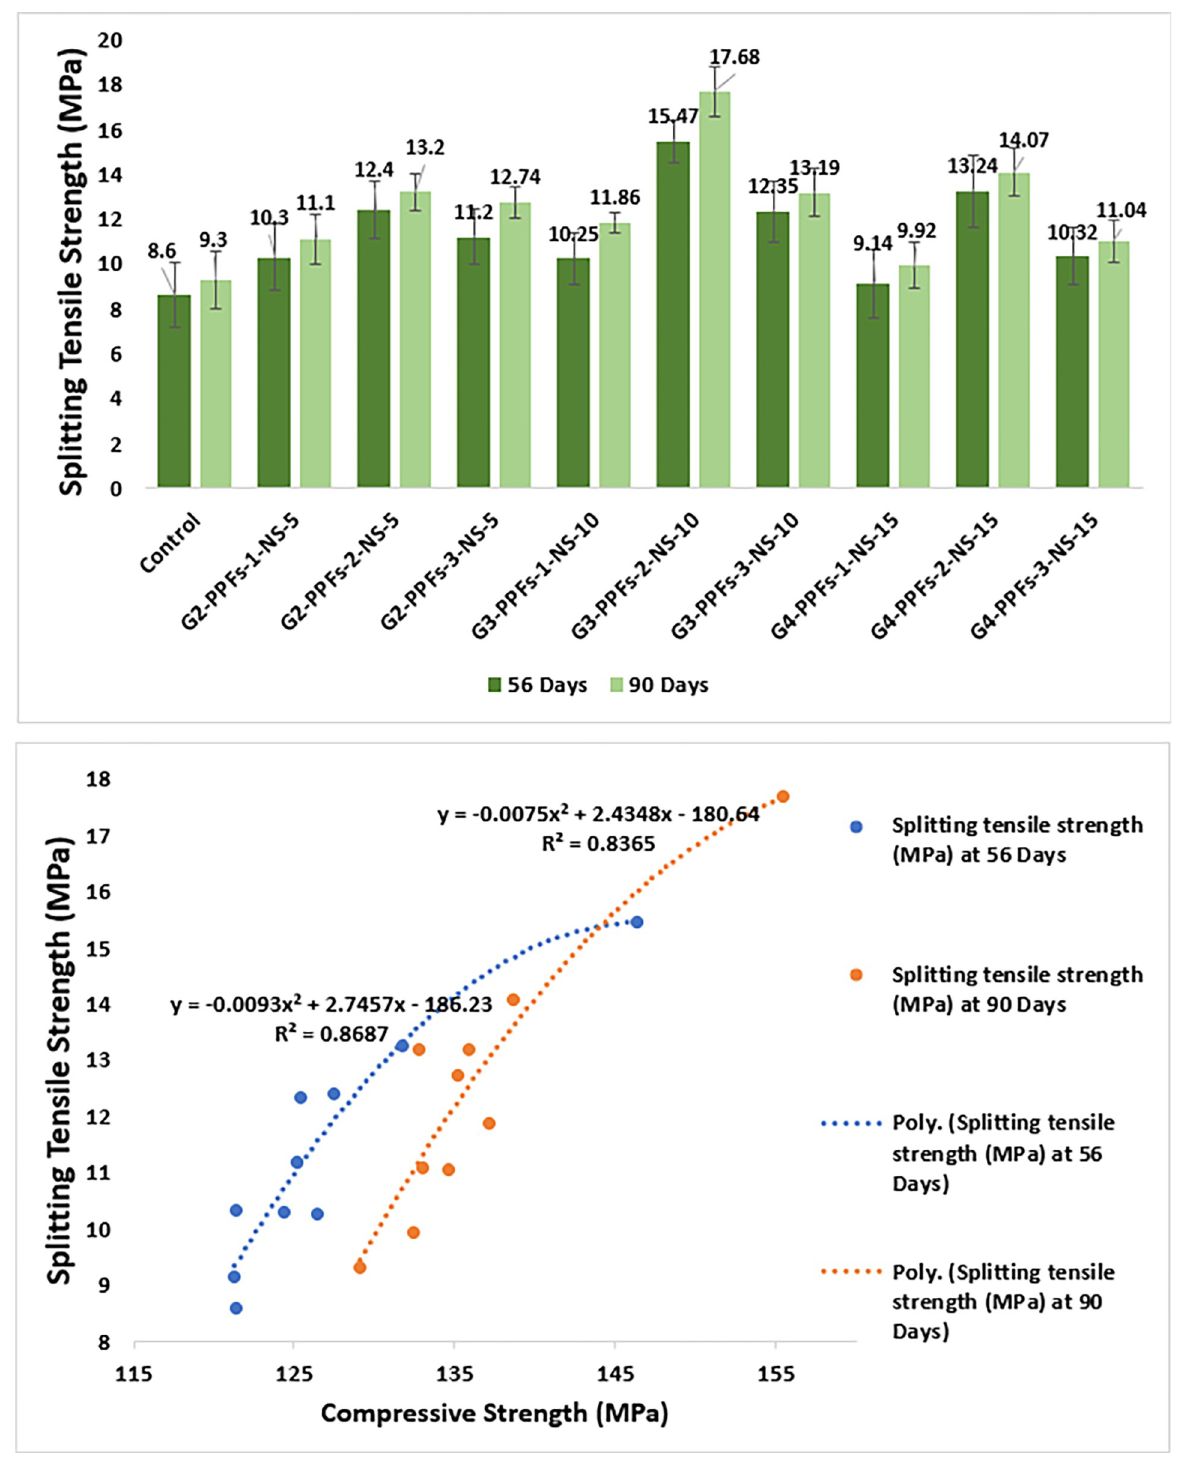
Fig 12. (a) Splitting tensile strength of UHS-GPC at 56 and 90 days. (b) Polynomial regression analysis to predict splitting tensile analysis employing compressive strength (MPa).